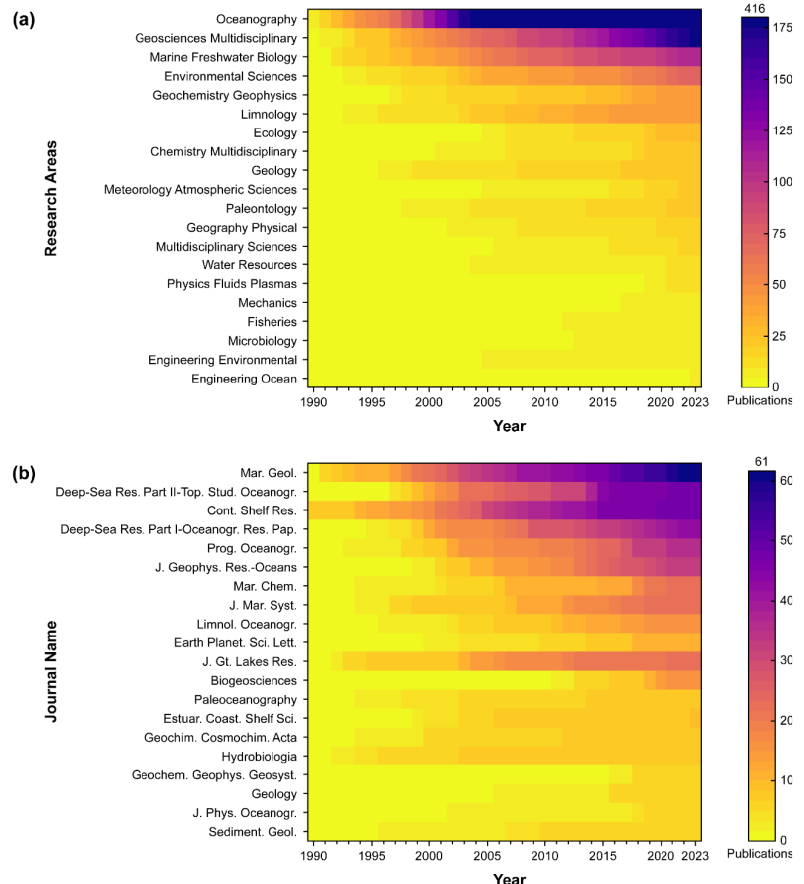
Figure 4. Research areas and sources of publication analysis of nepheloid layer research from 1990 to 2022. ( a ) The top 20 most productive research areas’ annual evolutionary trends. ( b ) The top 20 most productive journals’ annual evolutionary trends.